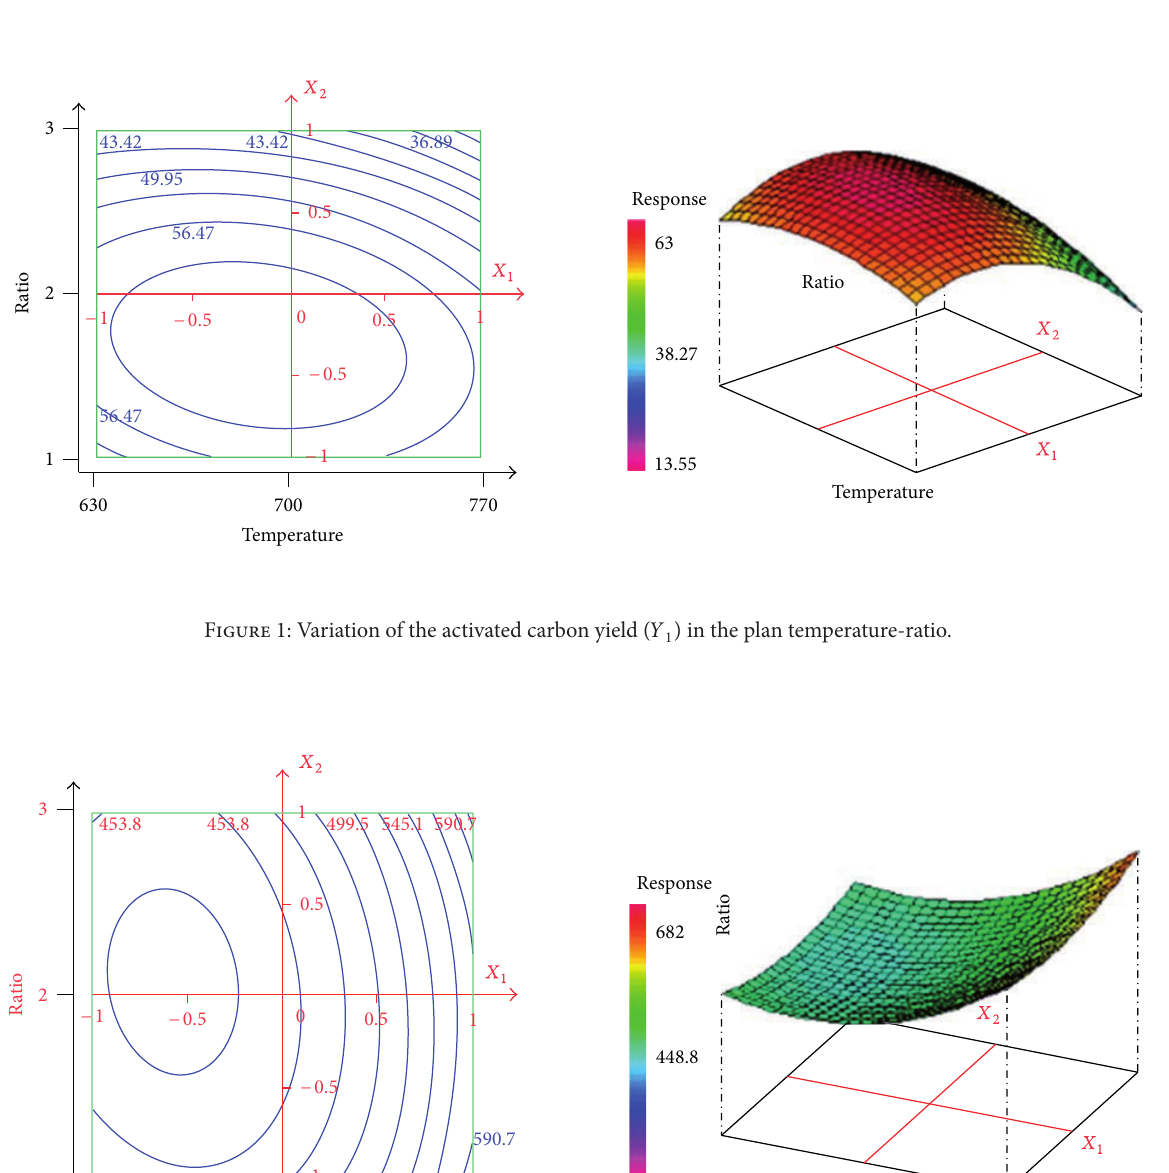
Source of variation Sum of square Degree of freedom Square mean Rapport Signif. Regression